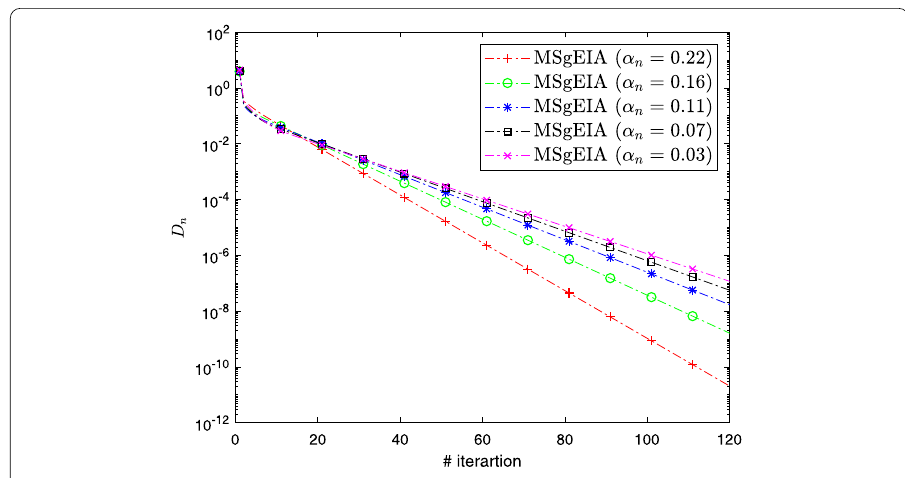
Figure 1 Experiment 5.1: Algorithm 2 behavior in terms of iterations relative to different values of α n